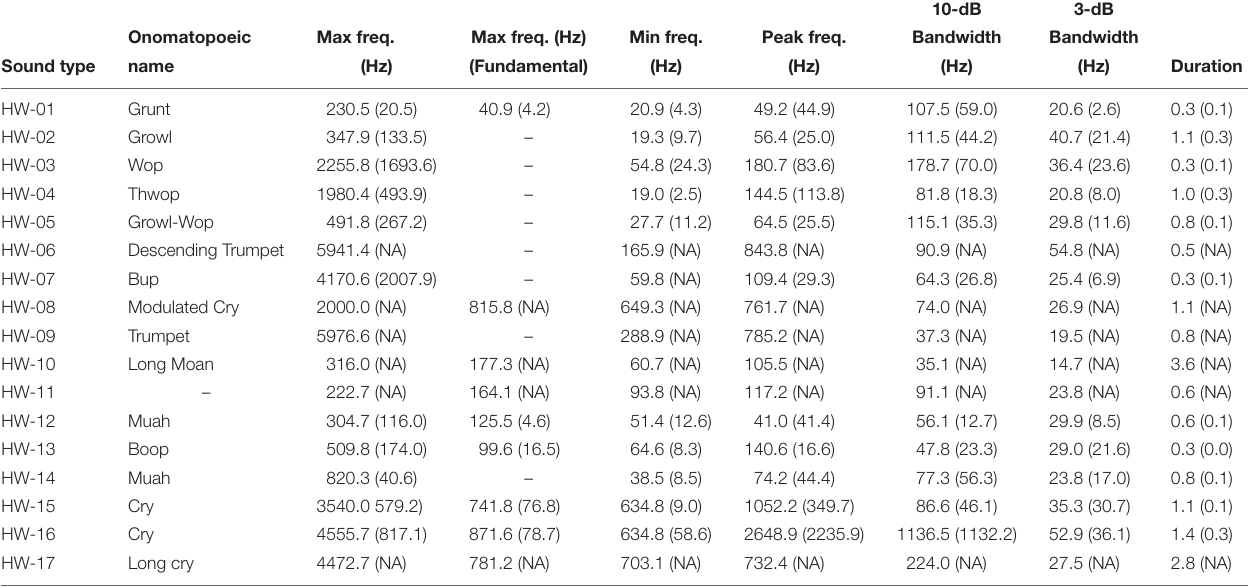
TABLE 4 | Mean spectrogram parameters of non-song sounds recorded in Geographe Bay and Port Hedland.